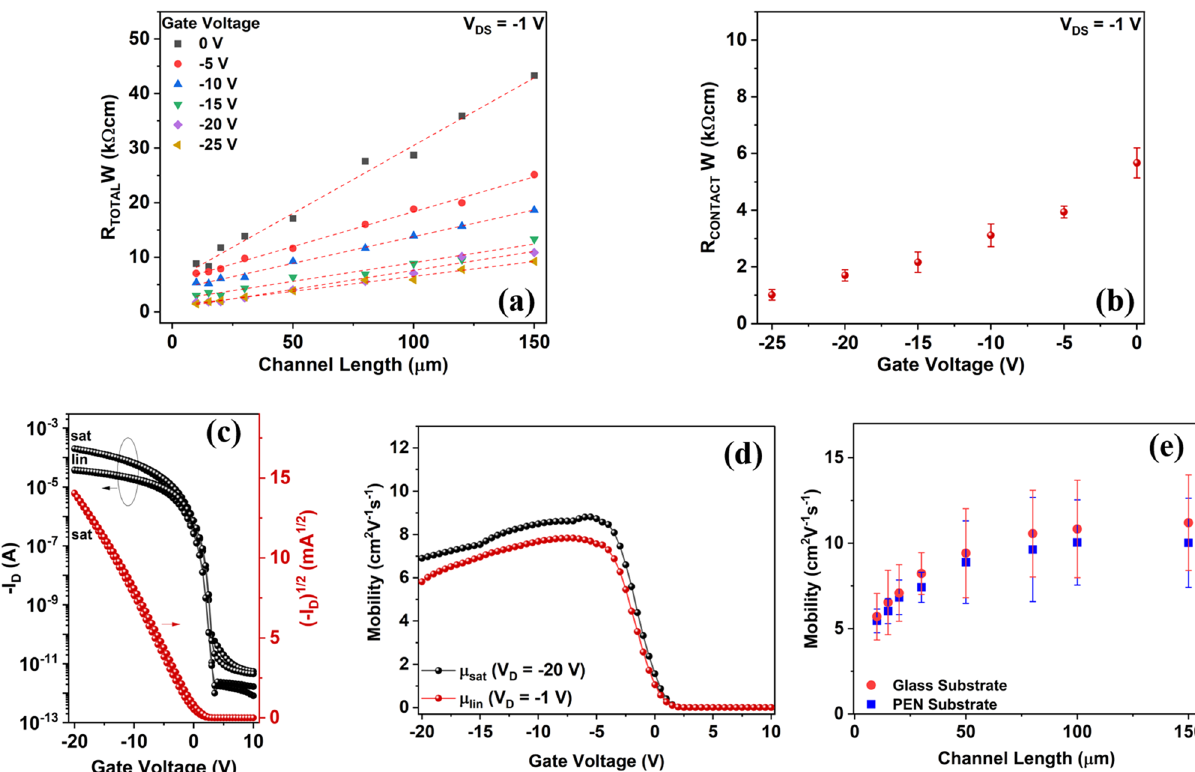
Figure 5. ( a ) Total device resistance (R TOTAL W) plotted as a function of the channel length for 4H–21DNTT OTFT for various gate overdrive voltages ( V G − V TH ). ( b ) Contact resistance calculated using the transmission line method (TLM) plotted as a function of gate overdrive voltages ( V G − V TH ). ( c ) Transfer characteristics of the 4H–21DNTT OTFT devices (W/L = 450 μm/15 μm) on Parylene C/glass substrate in the saturation region (V D = − 20 V) μ sat = 8.8 cm 2 V −1 s −1 and linear region (V D = − 1 V) μ lin = 6.8 cm 2 V −1 s −1 . ( d ) Saturation and linear mobility vs gate voltage plot for 4H–21DNTT OTFT prepared by shearing on Parylene C/glass substrate. ( e ) Average mobility with standard error vs channel length for 4H–21DNTT OTFT on both glass and flexible (PEN) substrate (For each channel length over 10 devices were used to calculate average